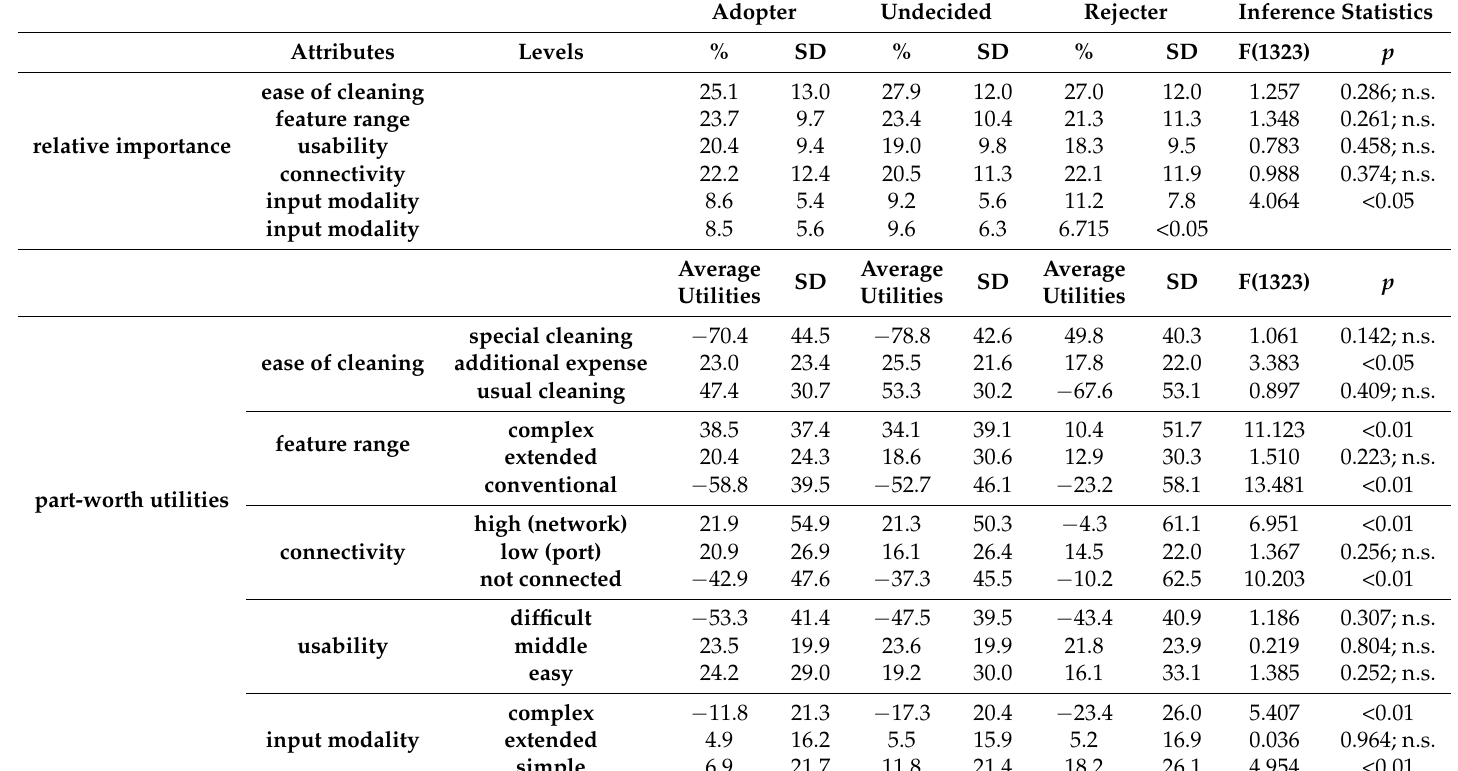
Table A3. Descriptive and inference statistics referring to the conjoint decisions referring to the smart armchair comparing three user